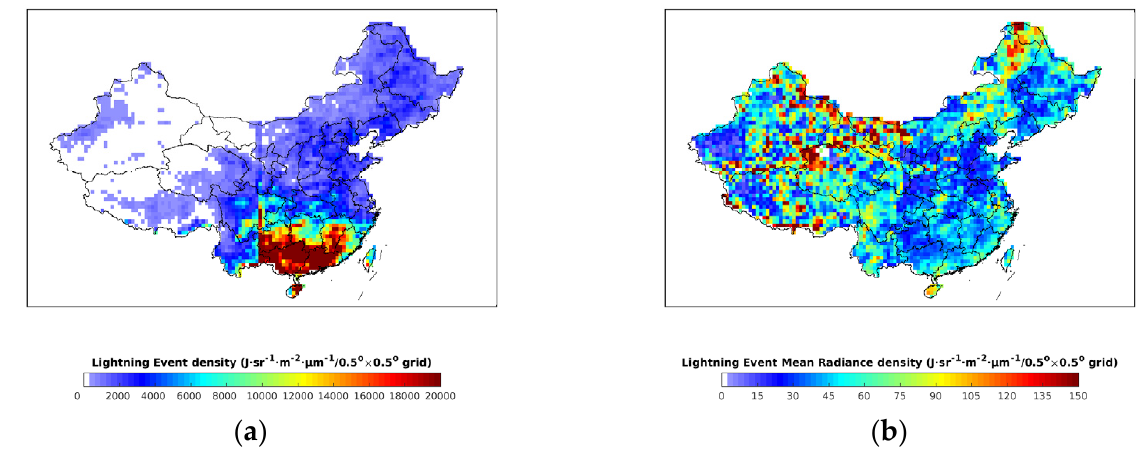
Figure 8. Spatial distribution features of the LMI Event. ( a ) The LMI Event density and ( b ) the LMI Event Radiance.